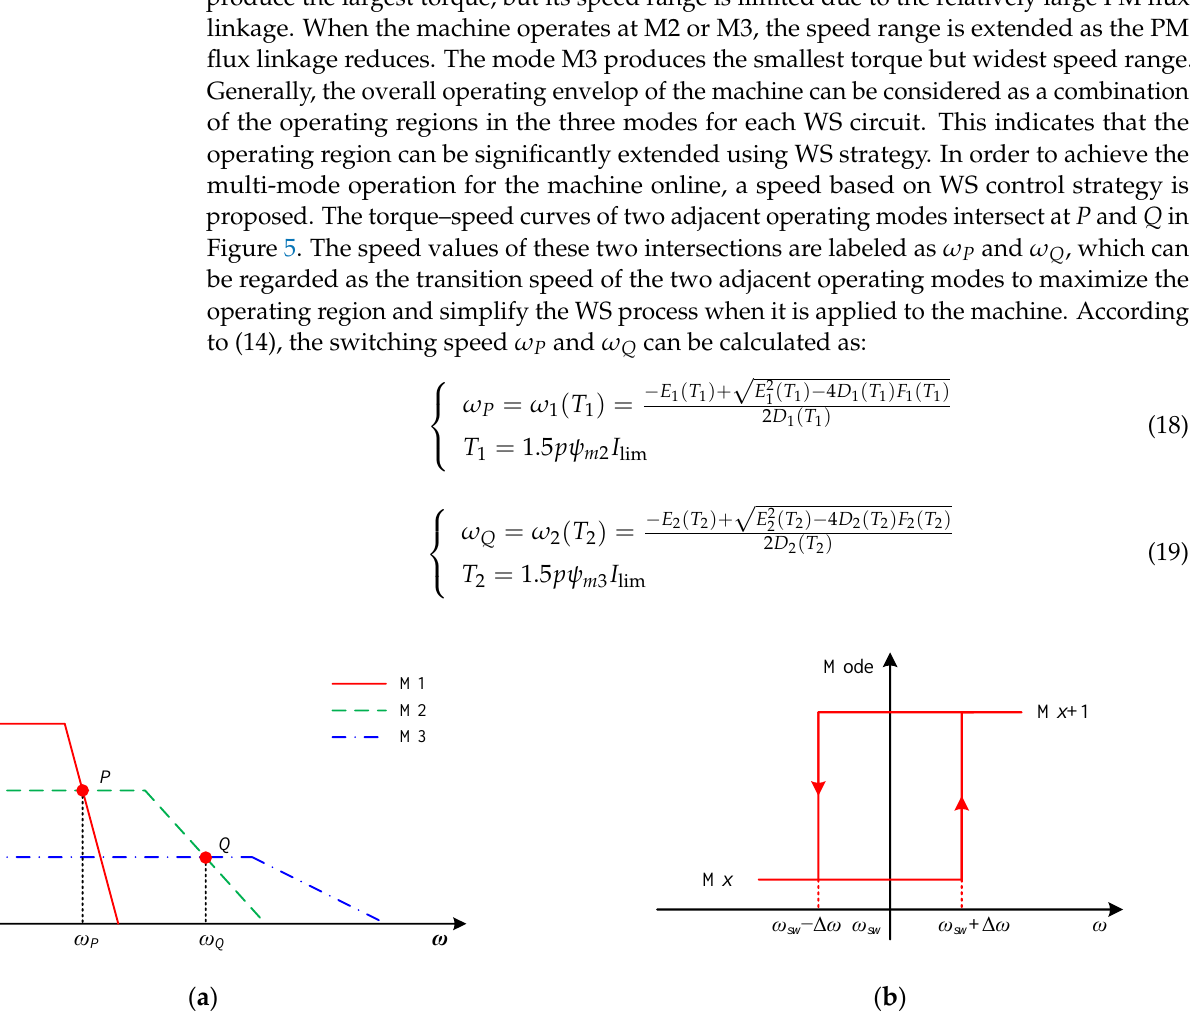
Figure 6. Schematic diagram of the WS strategy for the DS-PMM based on current vector control.